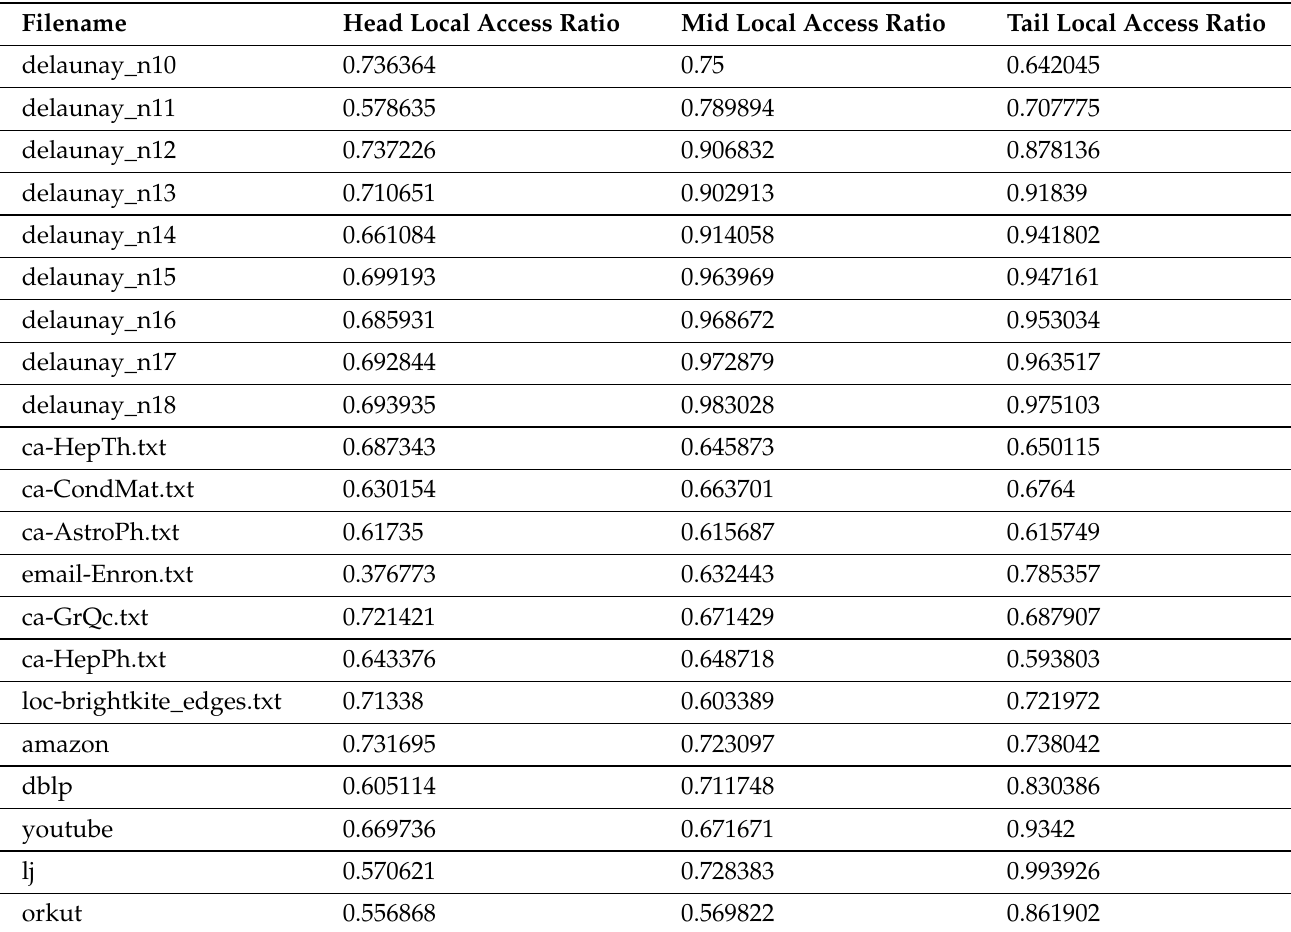
Table 5. Local Access Ratio of different stream graphs.